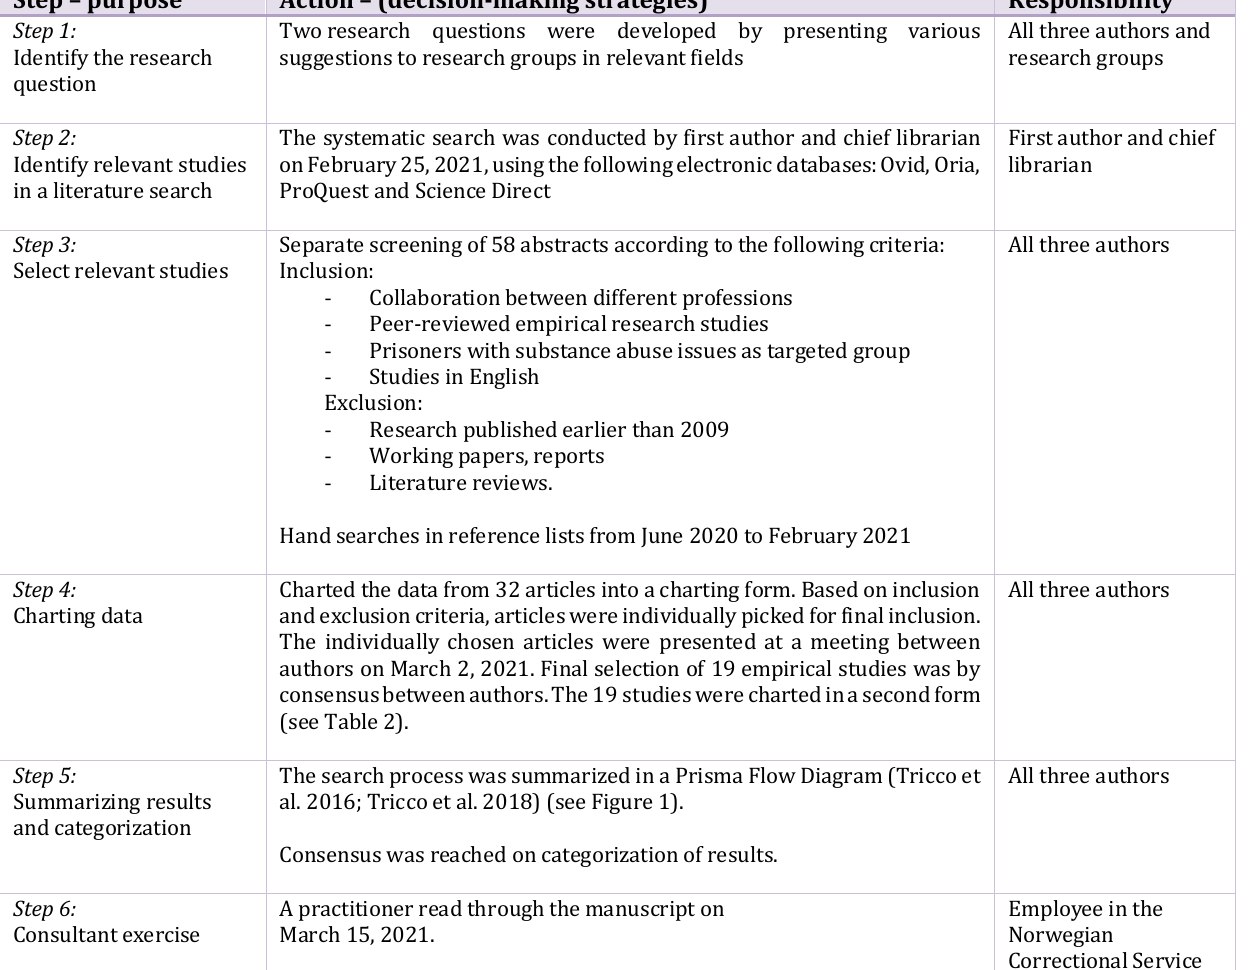
Table 1. Stepwise search procedure